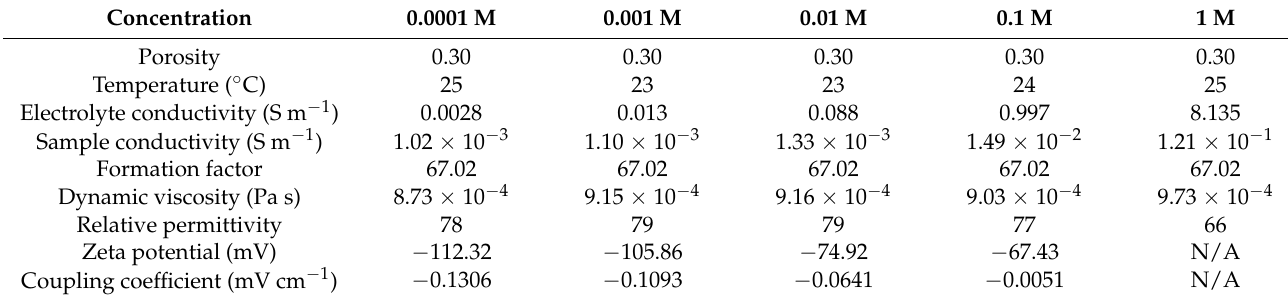
Table 3. Properties of SRM with different